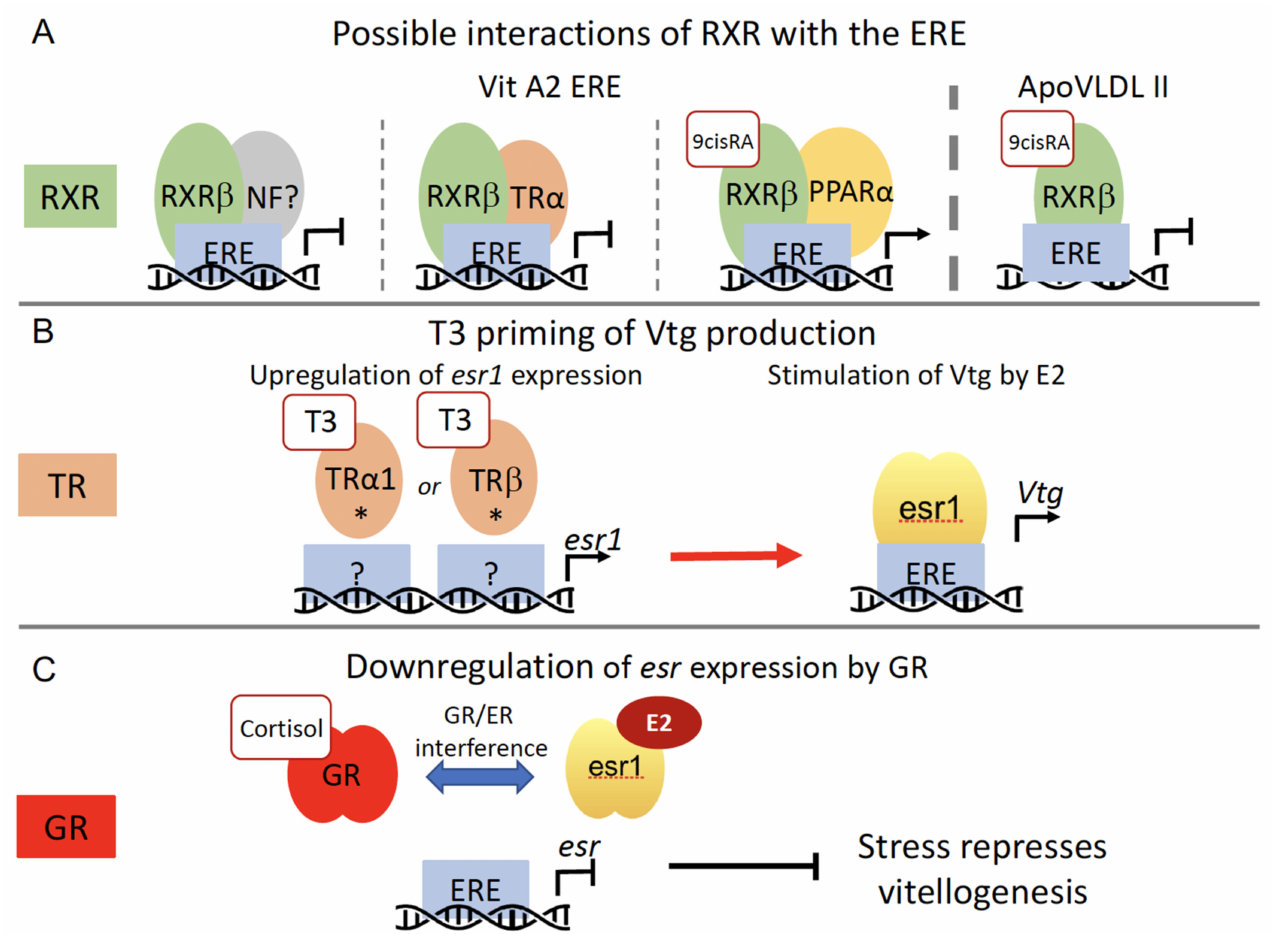
Figure 5. Examples of hepatic crosstalk between esr and other members of the nuclear receptors family in oviparous vertebrates. ( A ) Possible interactions of RXR with the ERE. ( B ) T3 priming of Vtg production. * Indicates that the molecular mechanism by which TR stimulates esr1 remains to be elucidated [126]. ( C ) Down-regulation of esr expression by GR leading to a repression of vitellogenin synthesis in stress situations [126]. E2: 17 β -estradiol; ERE: estrogen responsive element; Vtg: vitellogenin; RXR: retinoid X receptor; NF: nuclear factor; TR: thyroid receptor; PPAR α : peroxisome proliferator-activated receptor α ; 9cisRA: 9-cis-retinoic acid; T3: triiodothyronine; esr: estrogen receptor; GR: glucocorticoid receptor.